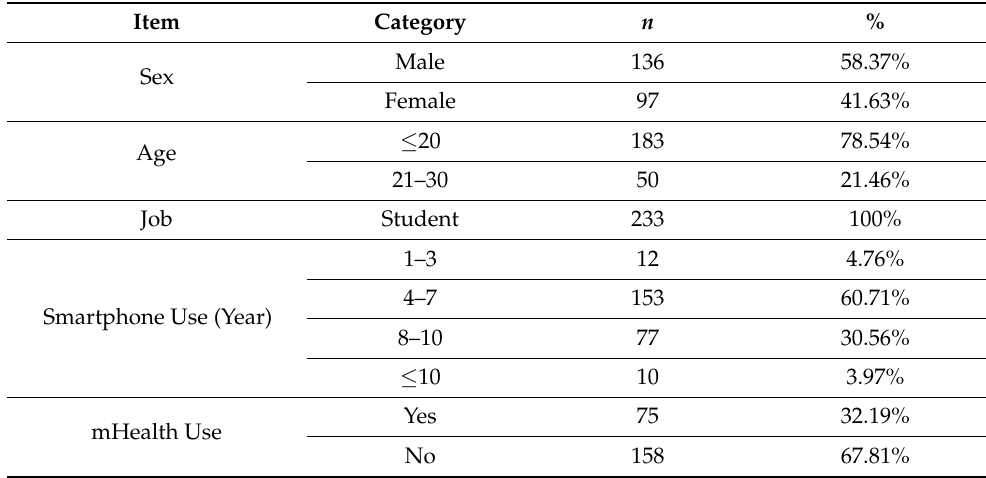
Table 1. Descriptive statistics of participants ( n =